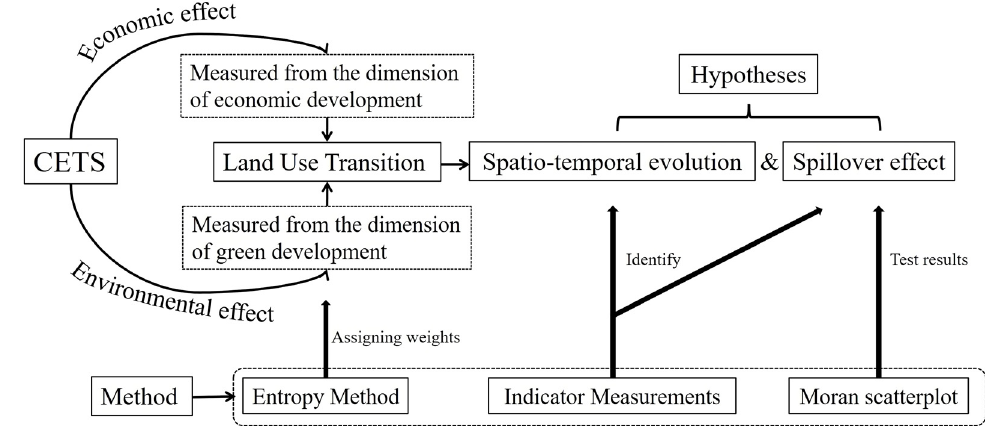
Figure 3. Diagram of the study strategy.